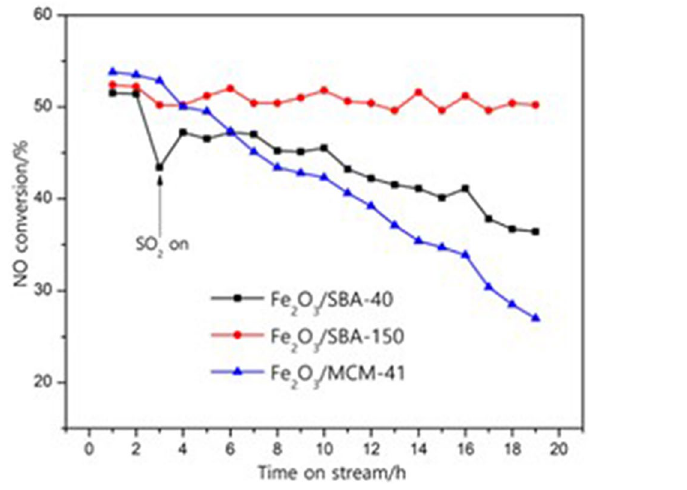
Figure 9. Sulfur resistance tests of catalyst 48